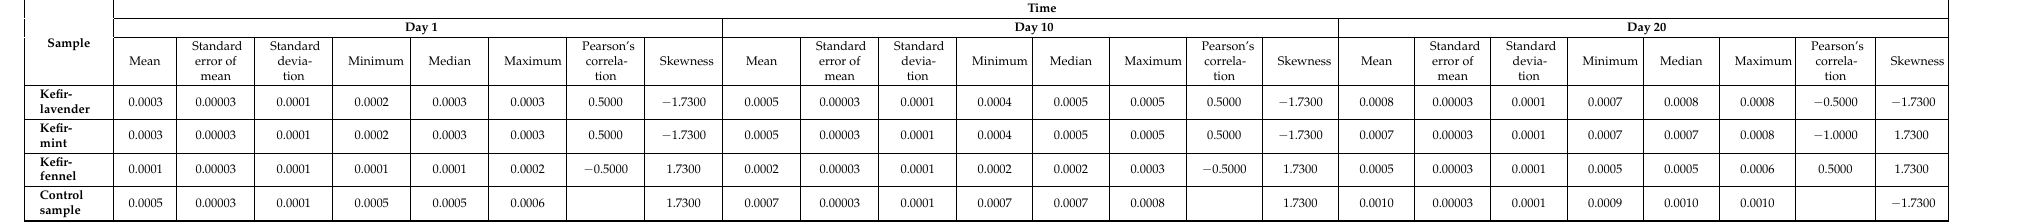
Table A6. Determination of ethanol